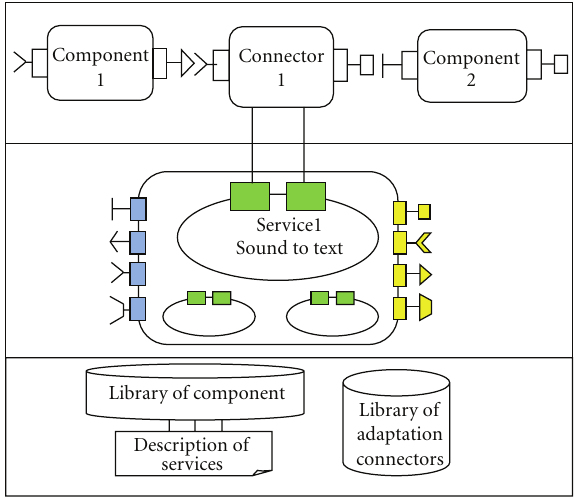
Figure 18: Use services of components in the adaptation task.